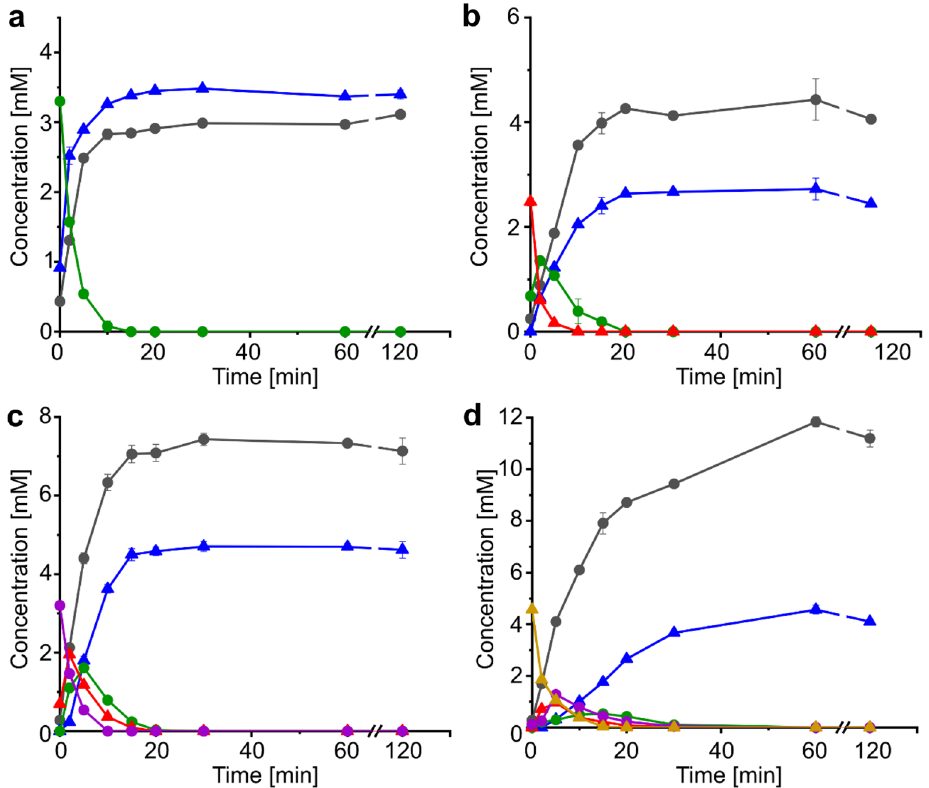
Figure 5. Hydrolysis of xylooligosaccharides by Be Rex8A. Substrates used were (a) xylotriose, (b) xylotetraose, (c) xylopentaose, and (d) xylohexaose. Concentrations are shown for xylose (gray circle), xylobiose (blue triangle), xylotriose (green circle), xylotetraose (red triangle), xylopentaose (purple circle), and xylohexaose (golden triangle). Data are presented as averages of triplicate experiments with standard errors of the mean.